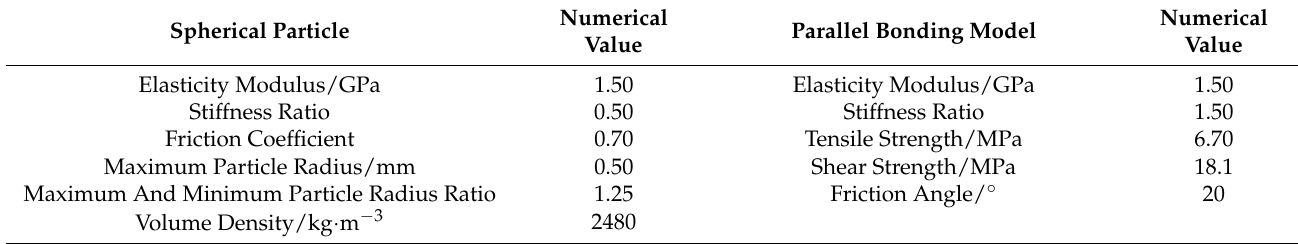
Table 2. Mesoscopic parameters of particle and parallel bonding models.